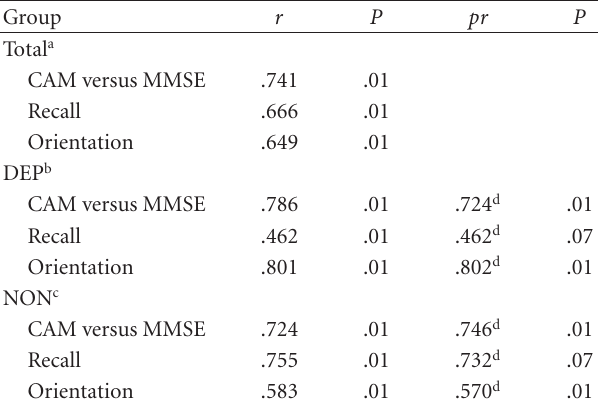
Table 3: Correlations between groups and subgroups of CAM